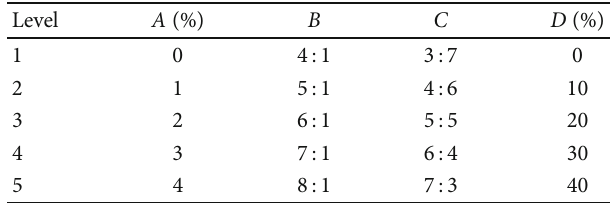
Table 1: Orthogonal test design level.